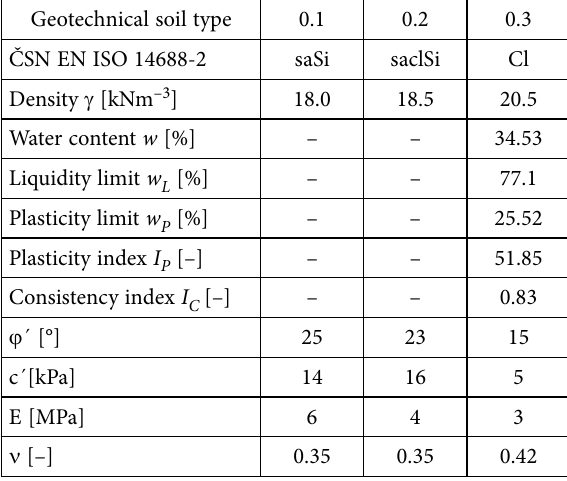
Table 1. Properties of soils (Balšínková, Hauser 2010) Geotechnical soil type